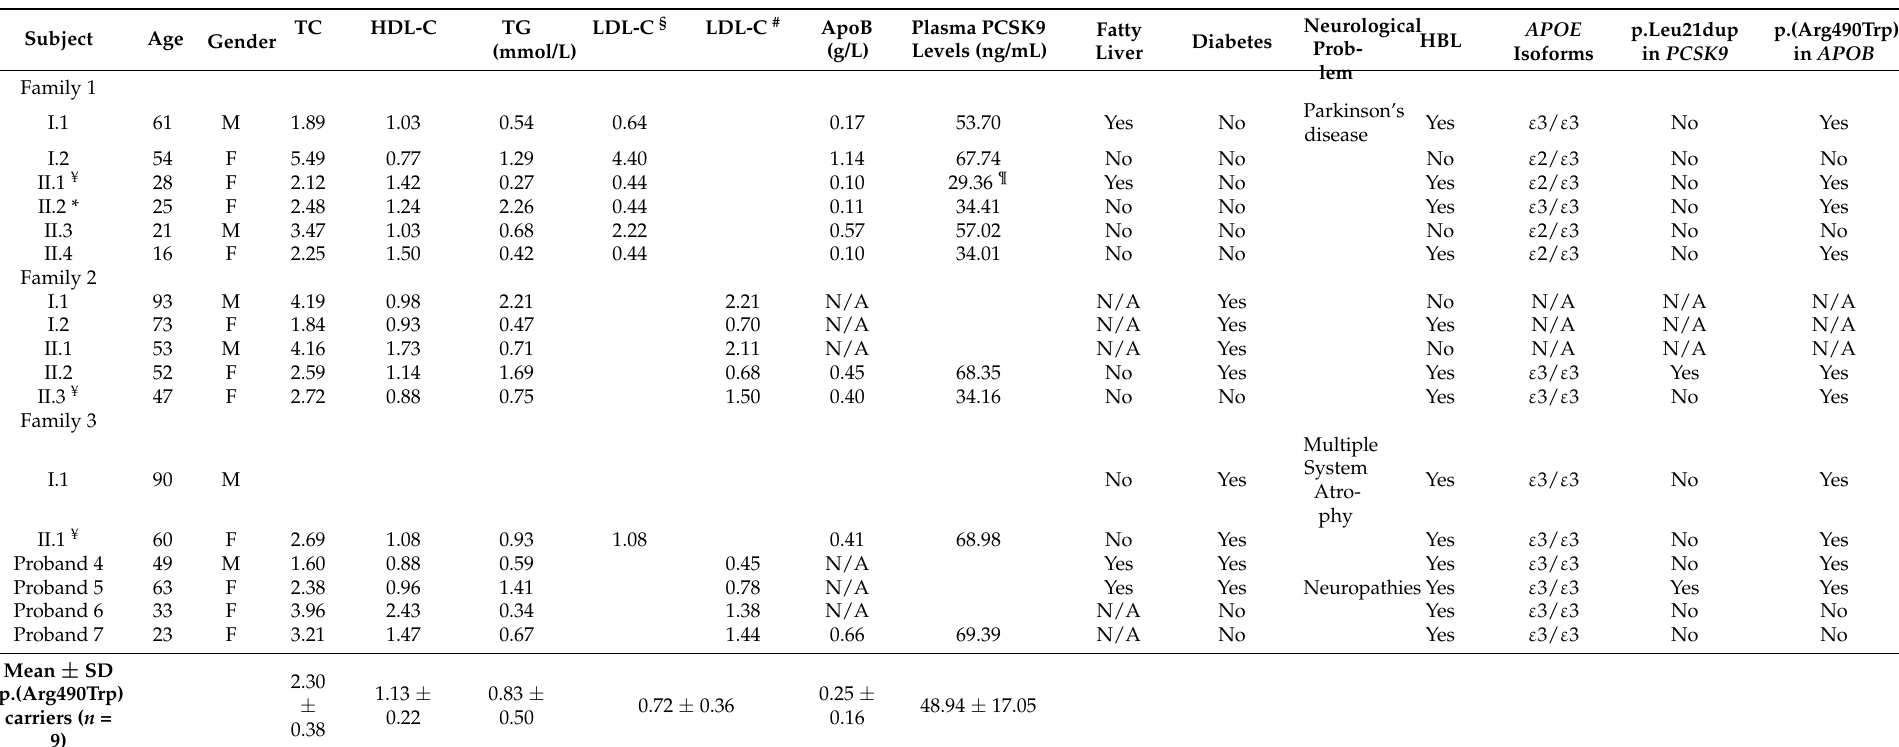
Table 1. Lipid measurements, clinical history (diabetes, liver disease and neurological problems) and genetic characteristics in the study